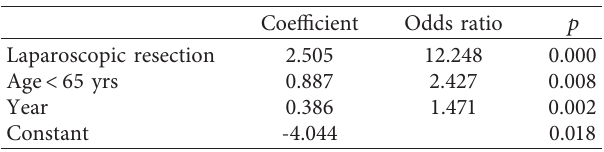
Figure 1: Distribution of outcomes. No patients for classes 3b, 3c, and 4b. Table 3: Multivariable